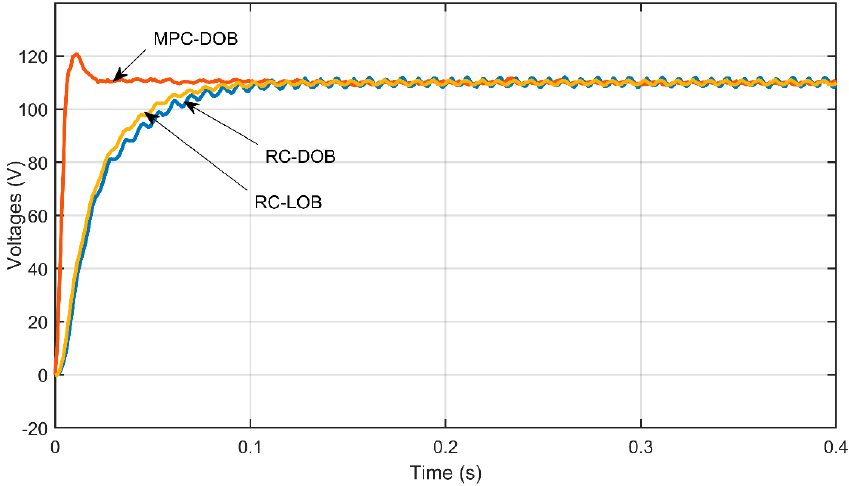
Figure 14. Transient response of MPC-DOB, RC-DOB, and RC-LOB under the inductive load.